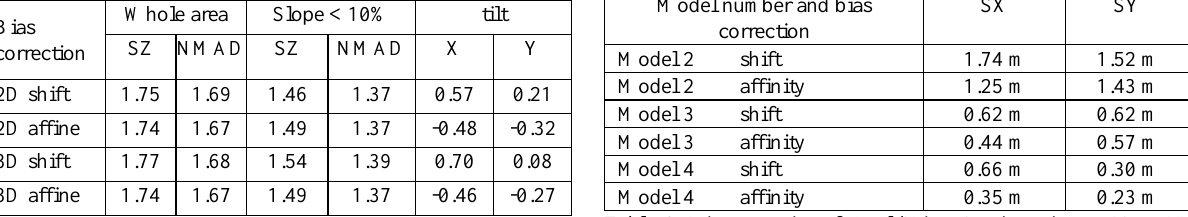
Table 5. Comparison of Pleiades DSM with reference points from aerial images with 30cm GSD